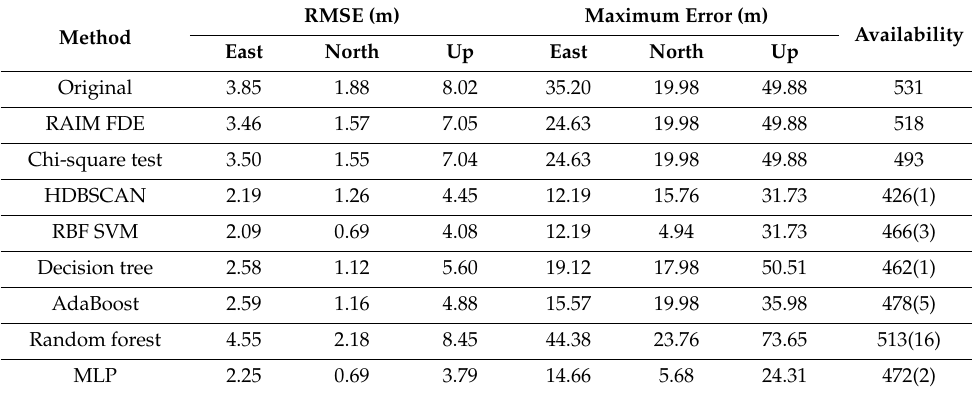
Table 10. Comparison of positioning accuracy and availability of D3 using di ff erent anomaly detection and exclusion